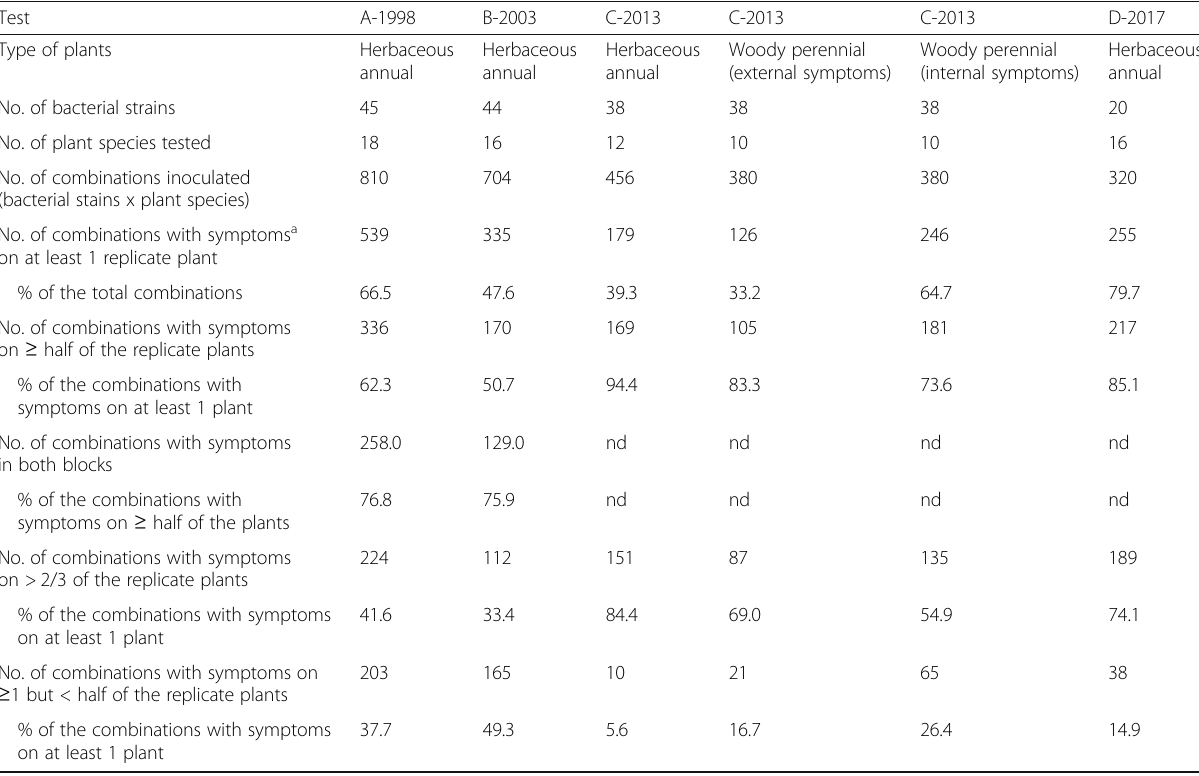
Table 1 Variability in the response of plants to inoculation with strains of Pseudomonas syringae for each of the four tests and for woody and herbaceous plants